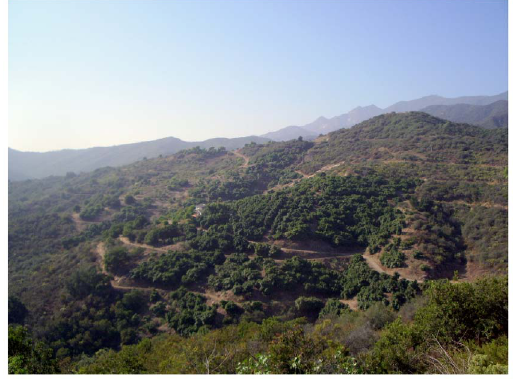
Figure 2. Orchard on hillslope. Typical landscape pattern of steep hills with orchards surrounded by